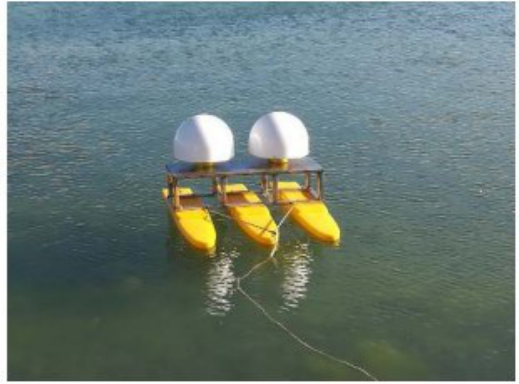
Figure 16. The GPSs mounted in a twined trimaran plastic platform [20].